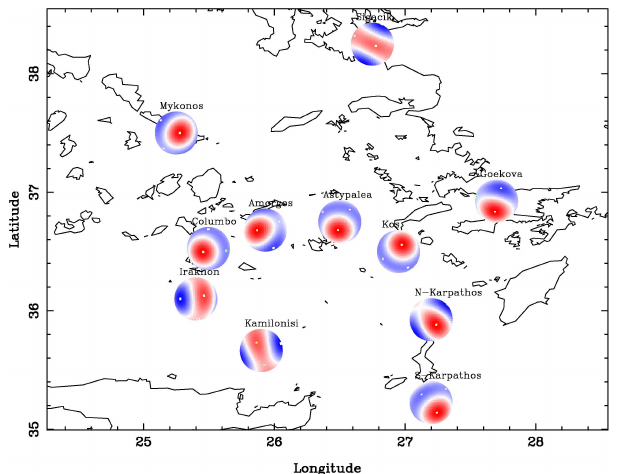
Fig. 11. Stress solutions visualized by distribution of normal stress versus fault plane